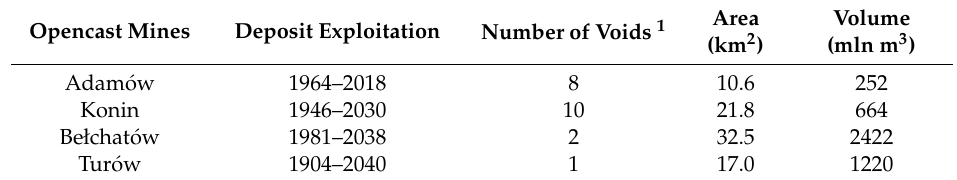
Table 1. Post-mining voids in the Polish lignite industry.